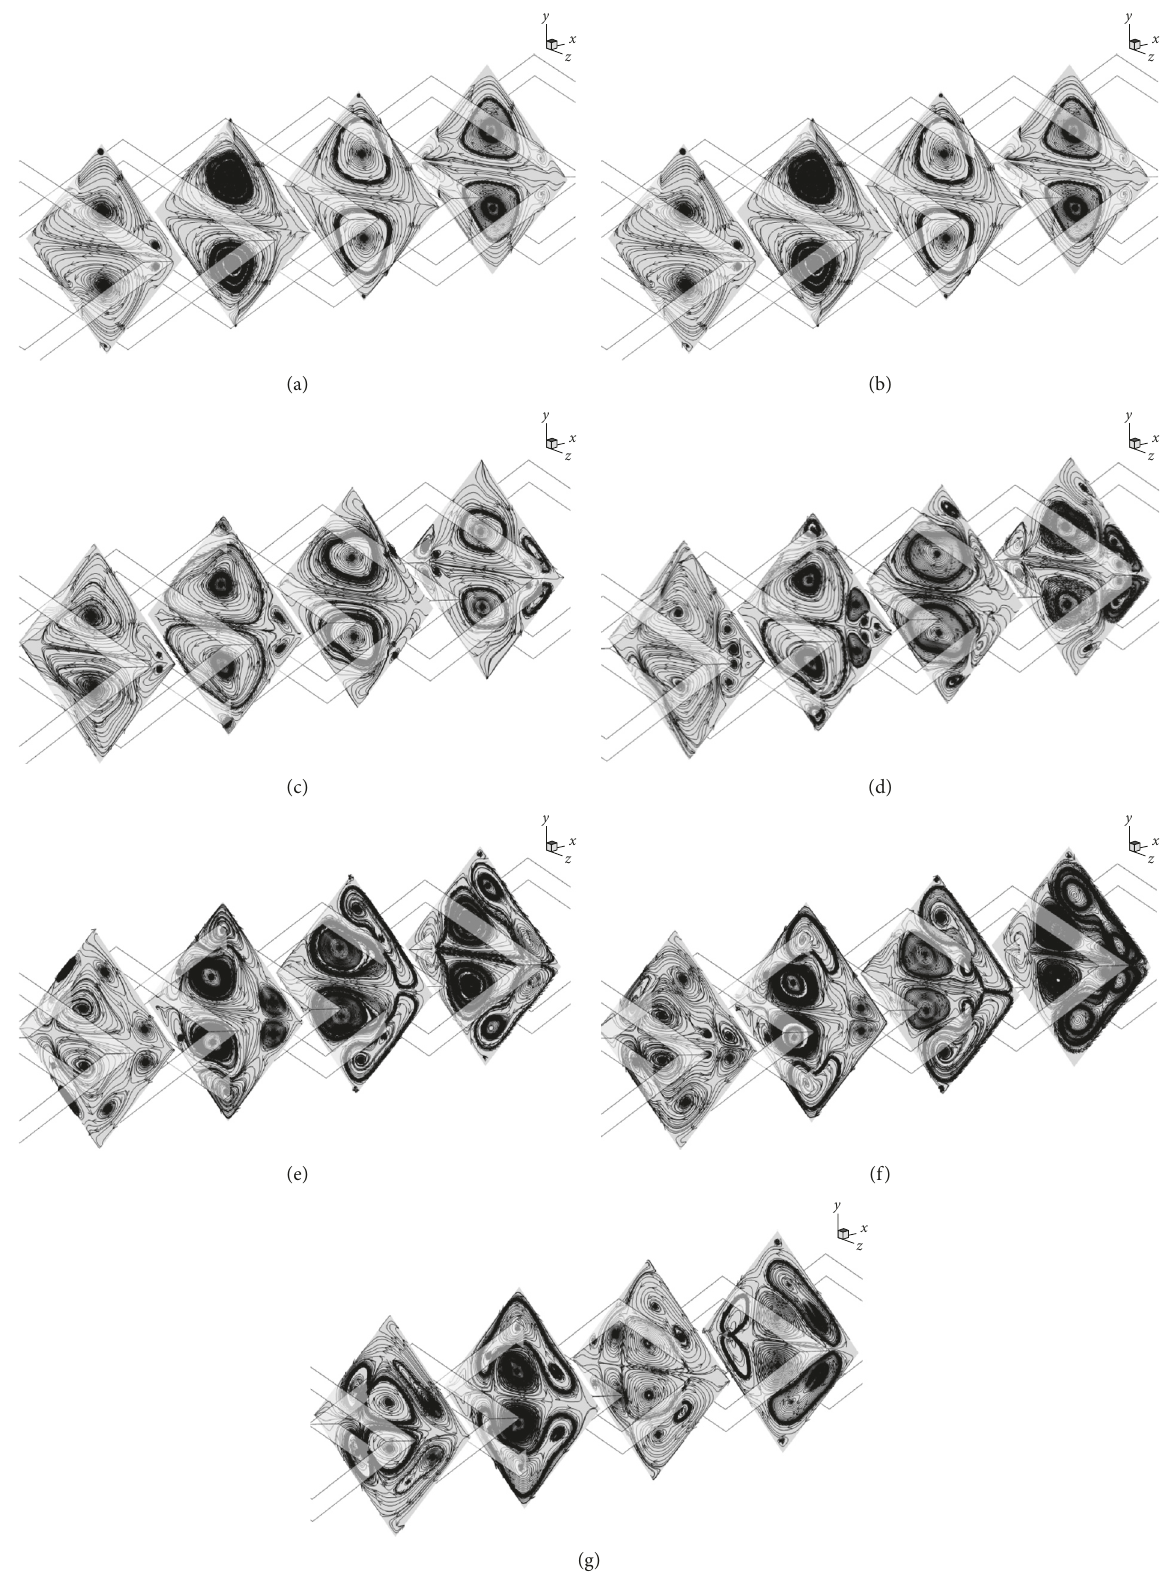
Figure 6: Streamlines in the y - z plane of the heat exchanger square duct installed with the 45 ° ISR for (a) s / H � 0, (b) s / H � 0.05, (c) s / H � 0.10, (d) s / H � 0.15, (e) s / H � 0.20, (f) s / H � 0.25, and (g) s / H � 0.30 at BR � 0.20 and Re �